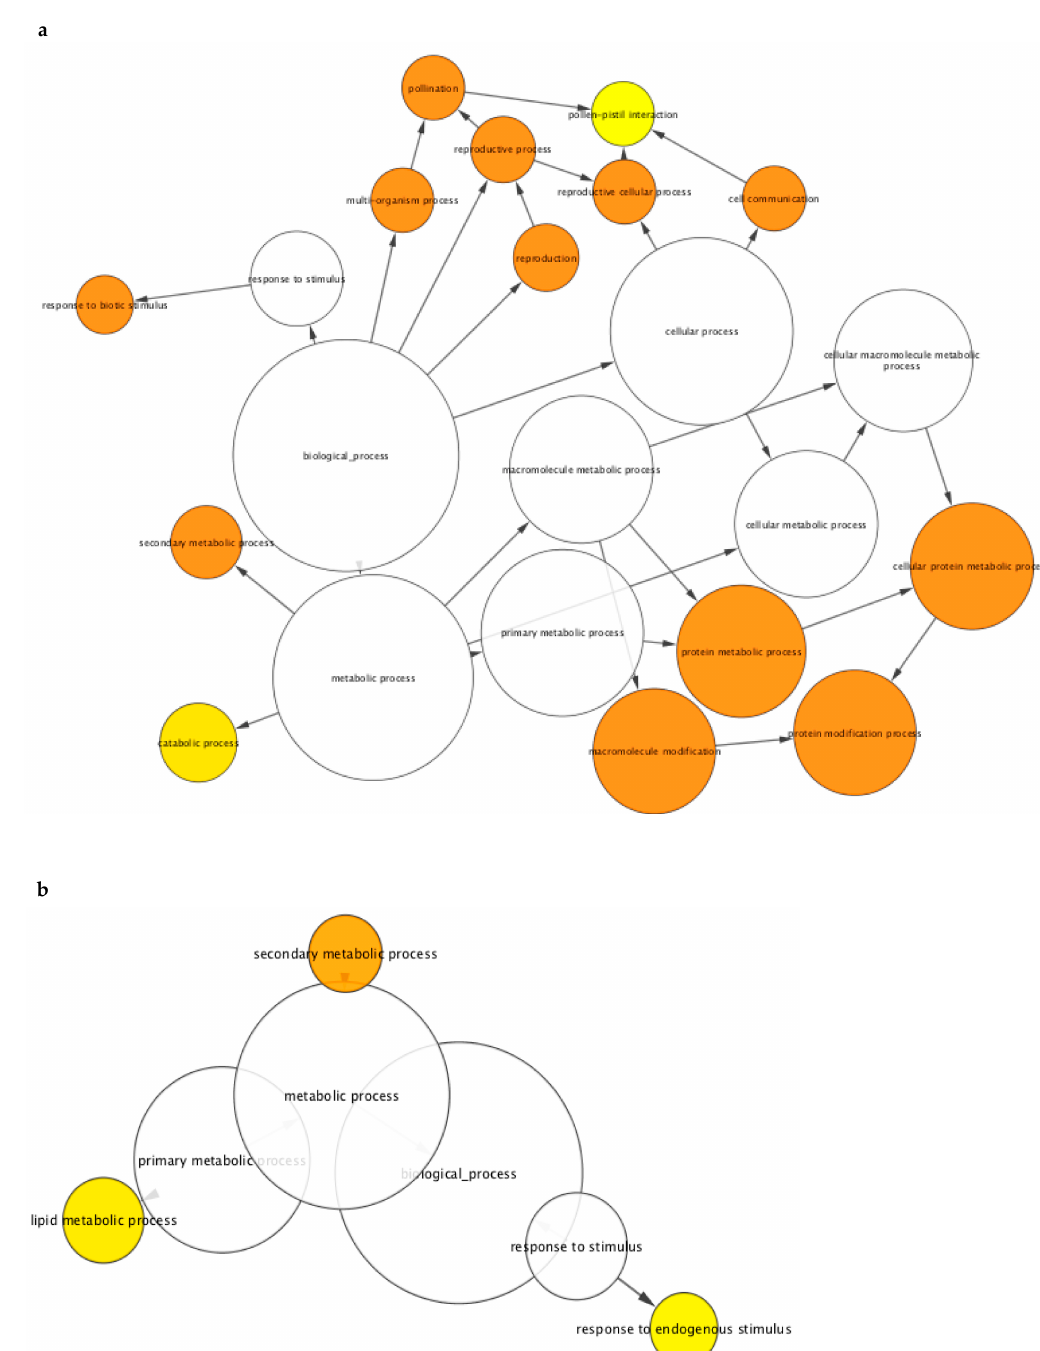
Figure 7. Gene Ontology (GO) functional category enrichment analysis among differentially expressed genes in mock-treated transgenic line L1 (L1m) compared to mock-treated empty-vector control plants (EVm). GO categories of ( a ) upregulated genes and ( b ) downregulated genes significantly enriched were analyzed with BINGO. The size of the nodes is proportional to the number of genes in the test set which are annotated to that node while the color of the node represents the corrected p -value. The node color scale ranges from white (not significantly over-represented), yellow ( p -value < 0.05) to dark orange ( p -value < 10 − 5 ×